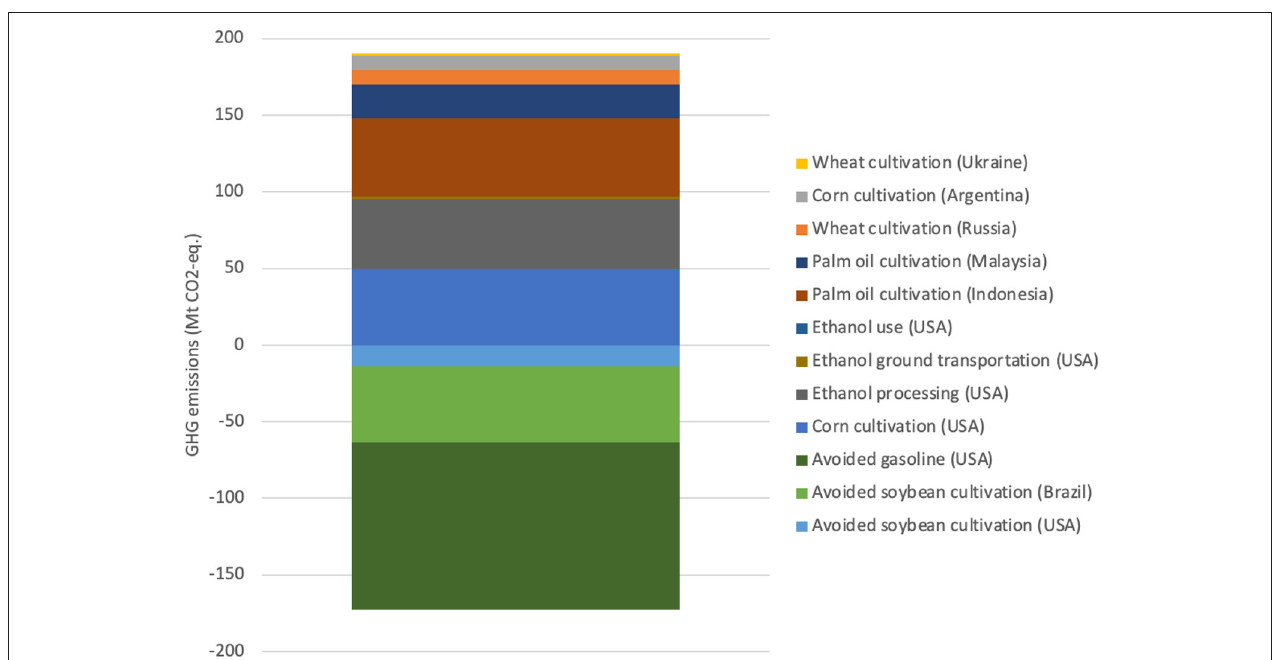
FIGURE 4 | Global annual emissions associated with producing 15 billion gallons of corn ethanol in the USA.